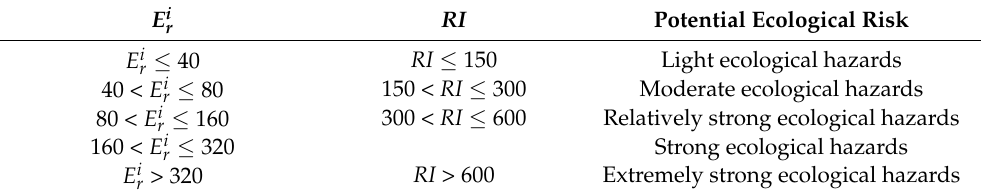
Table 1. The classification criteria of the potential ecological risk